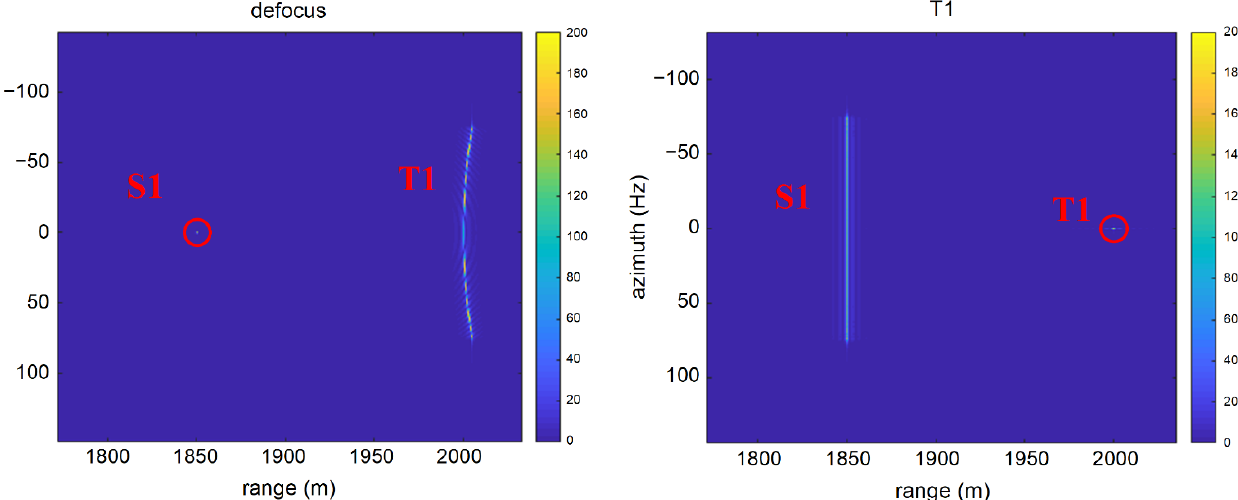
Figure 9. Comparison before and after the refocused of T1. Case 2: target position y ≠ 0 at t azi = 0